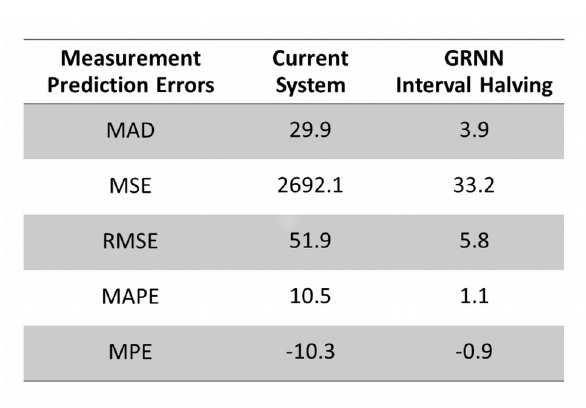
Table 6. Comparison of the results among the three of the optimization